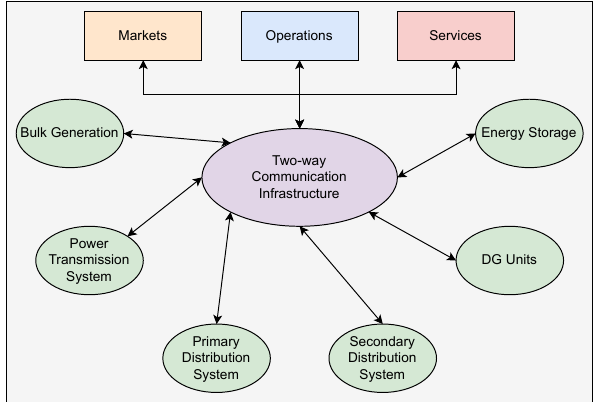
Figure 1. Smart grid building